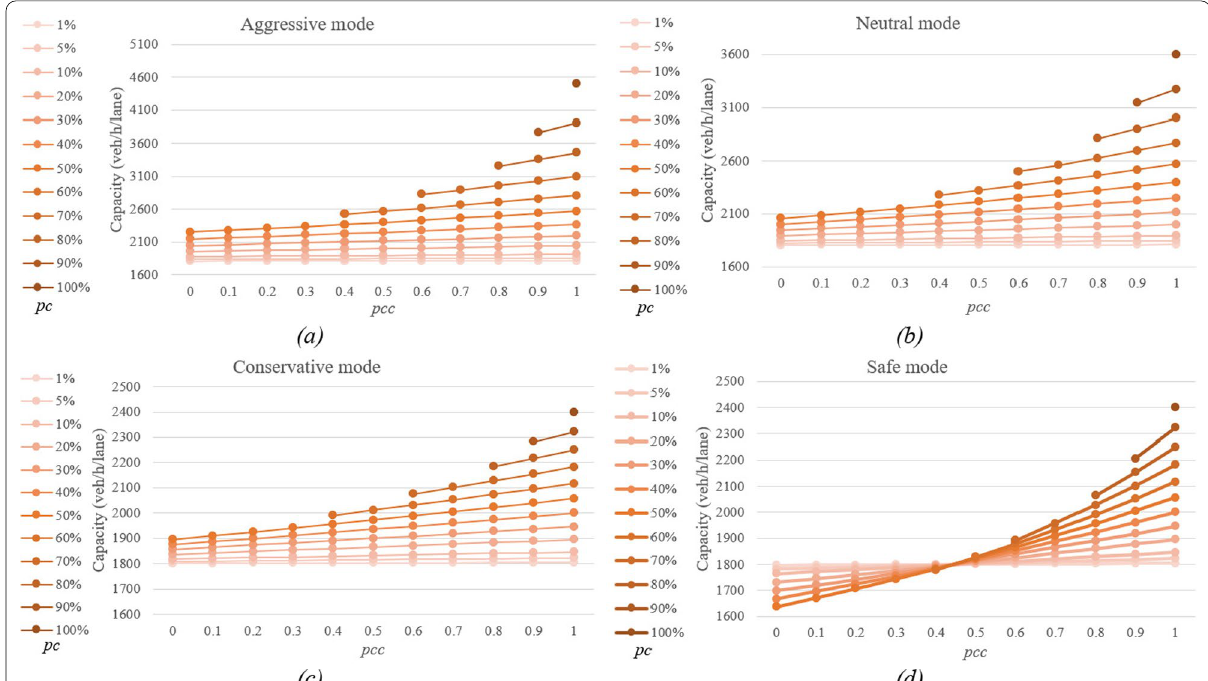
Fig. 3 Capacity of a mixed lane under the different driving modes, p C and p CC . Note : p C is the CAV penetration rate of a mixed traffic in a lane, and p CC is the rate of CAV forming platoons to all CAVs in a